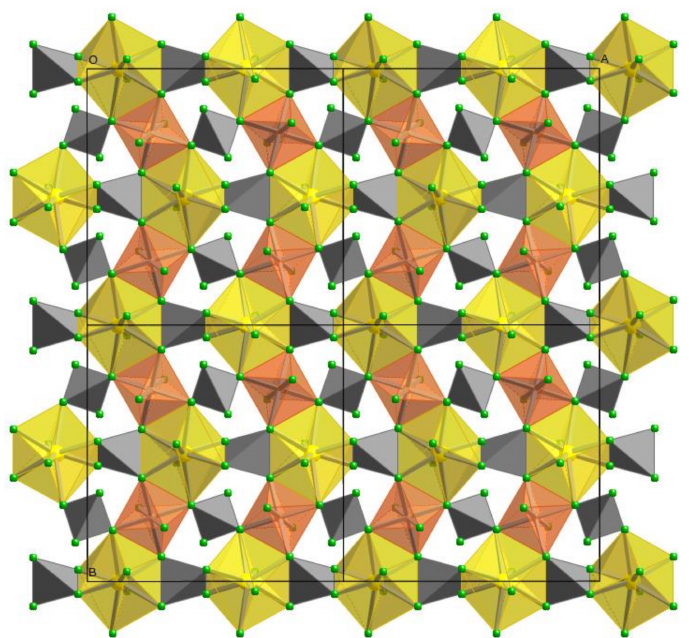
Figure 1. Projection of a section of the grossular structure down the c axis showing the XO 8 dodeca- hedra (yellow), YO 6 octahedra (orange), ZO 4 tetrahedra (grey), and O atoms (green spheres). The prominent edge-sharing and zig-zag arrangement of alternating octahedra and dodecahedra are clear from the four unit cells outlined (black lines). The X and Z sites contain Ca and Si atoms, respectively. The Y site contains both Al and Fe